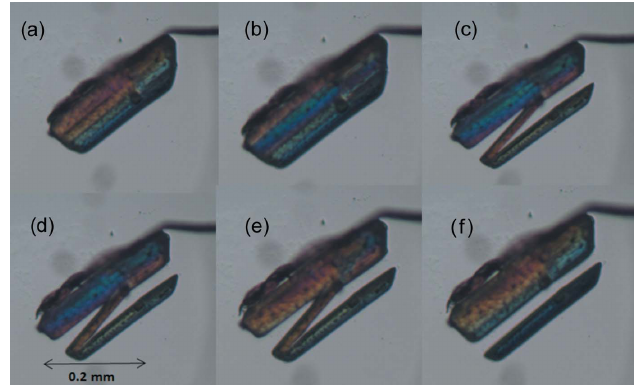
Figure 14 Thermal stage measurements of dl -Oct. ( a )–( c ) II ! I transition at 442.8, 442.4 and 441.6 K, respectively. ( d )–( f ) I ! II transition at 443.5, 444.6 and 445.6 K, respectively.